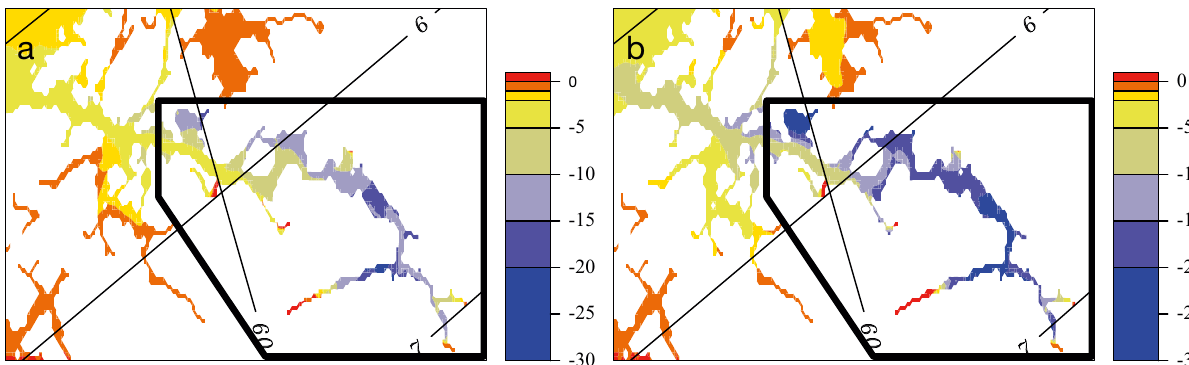
Fig. 11. Change (%) in annual secondary production for (a) 2019 and (b) 2020 between the reference simulation (S0) and the simulation with very high biomass